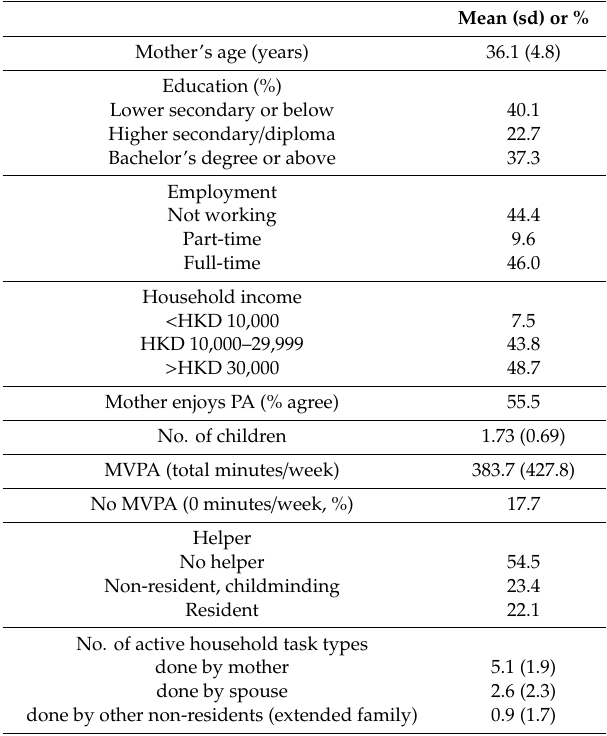
Table 1. Sample characteristics (N = 322).